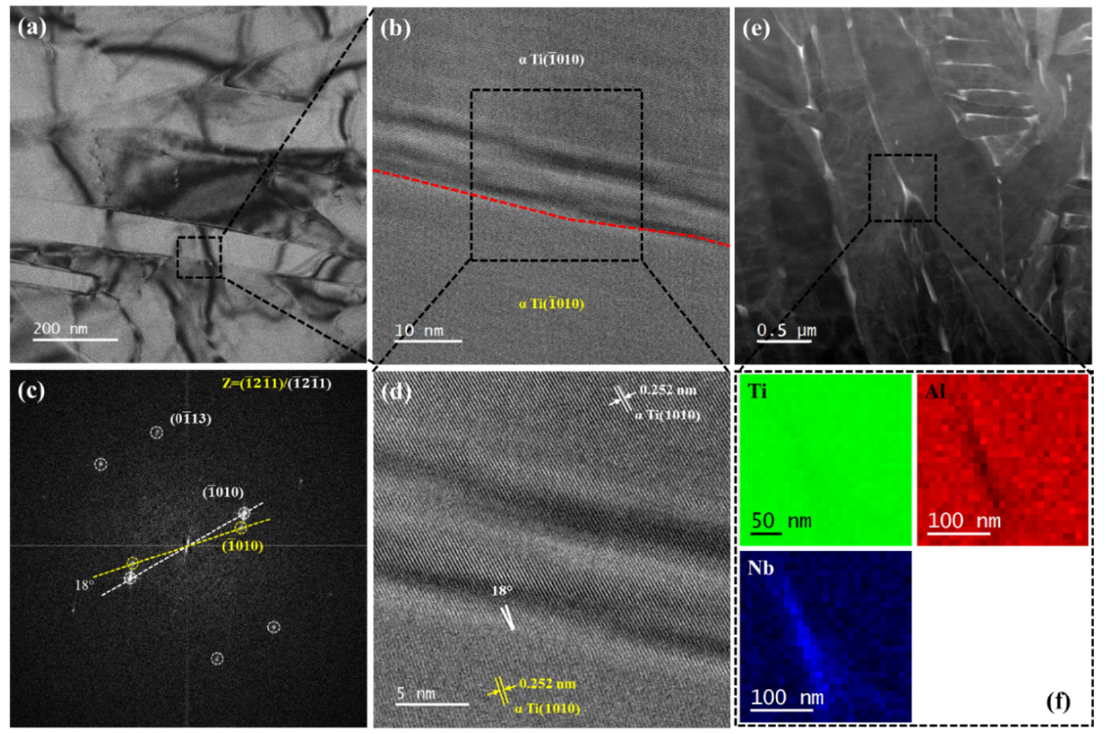
Figure 5. ( a ) TEM image of the HT3 sample; ( b ) HRTEM image from the black square area in ( a ), the red line indicates the boundary between two α -laths; ( c ) FFT pattern from the black square area in ( b ); ( d ) HRTEM image from the black square in ( b ); ( e ) HAADF-STEM image of the HT3 sample; ( f ) EDS maps of black square region in ( e ).